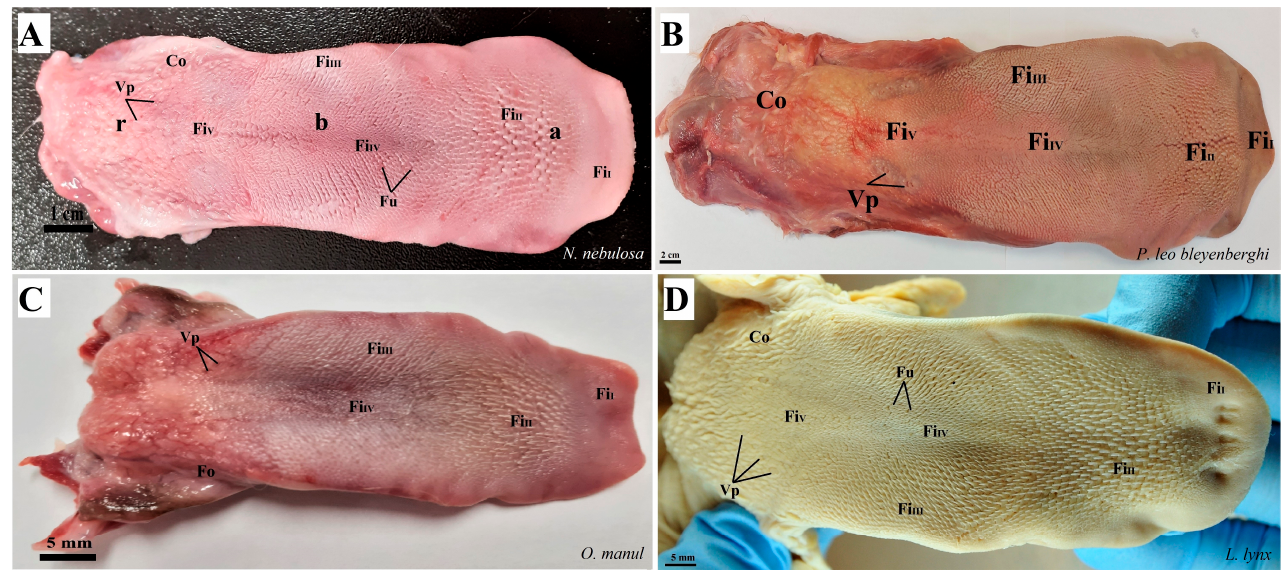
Figure 2. Photograph of the dorsal surface of the tongue of four species of undomesticated Felidae: N. nebulosa ( A ), P. leo bleyenberghi ( B ), O. manul ( C ) and L. lynx ( D ). Bar = 2 cm ( B ); bar = 1 cm ( A ); bar = 5 mm ( C , D ). Abbreviations: a—apex of the tongue, b—body of the tongue, Fi I —filiform papillae